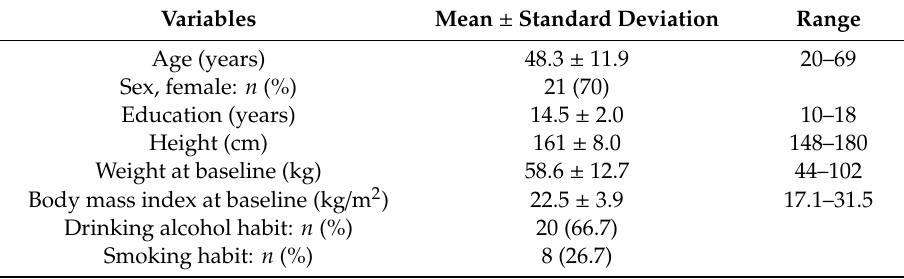
Table 1. The clinical characteristics of the